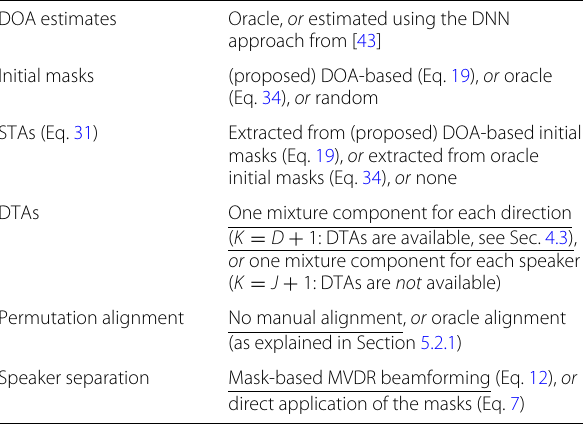
Table 1 Overview of different options for various components of the system considered throughout the experiments. If nothing else is explicitly stated, the underlined default is